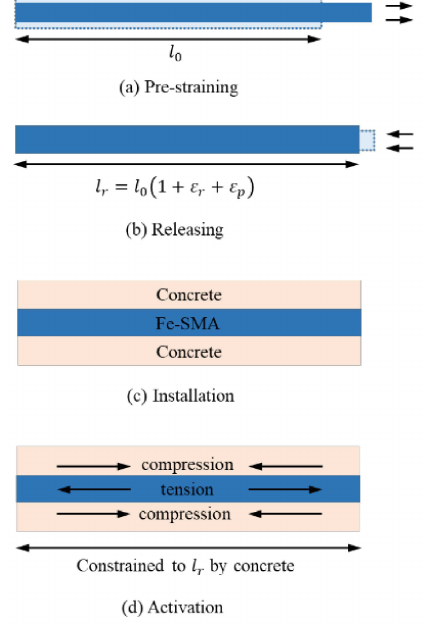
Figure 7. The process of strengthening RC beams with Fe-SMA strips [93].